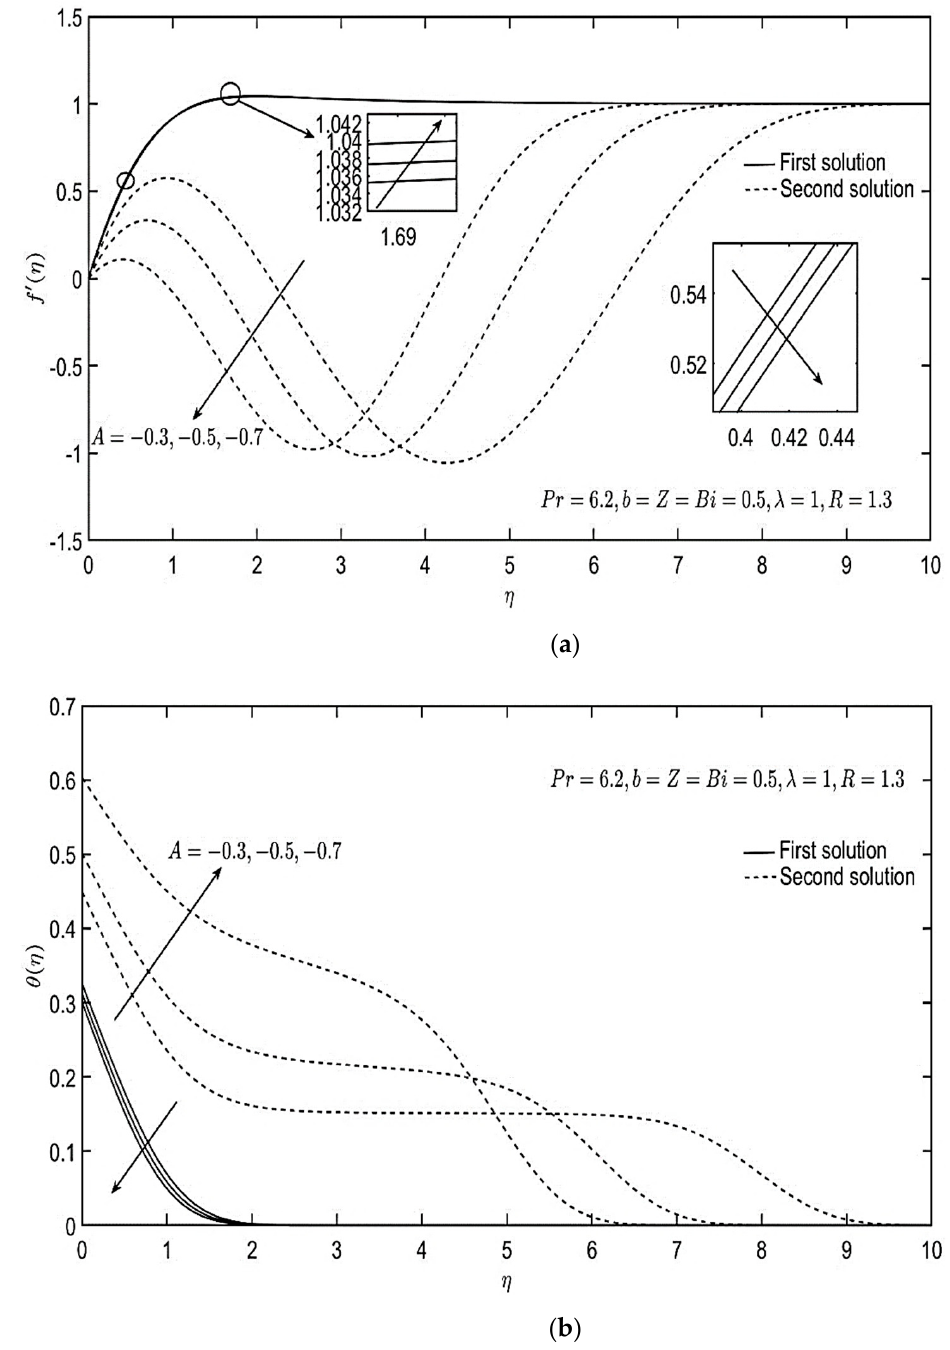
Figure 5. ( a ) Velocity and ( b ) temperature distributions for various values of 𝐴 .